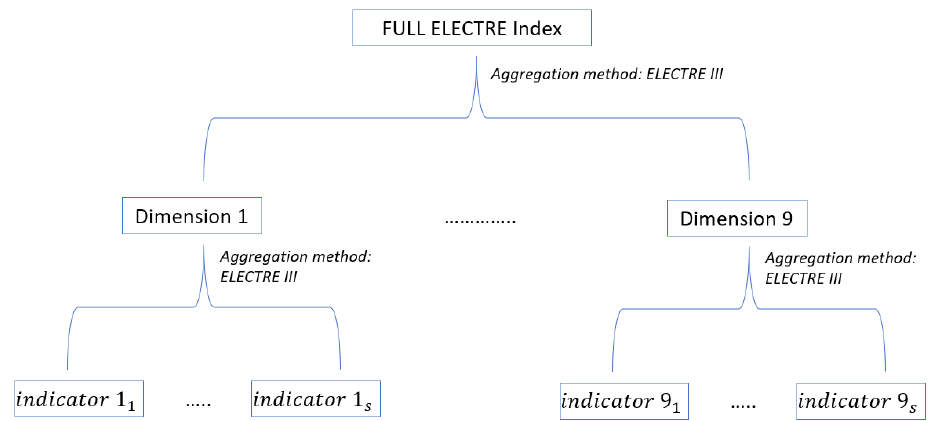
Figure 3. The second variation that we propose: FULL ELECTRE Index.